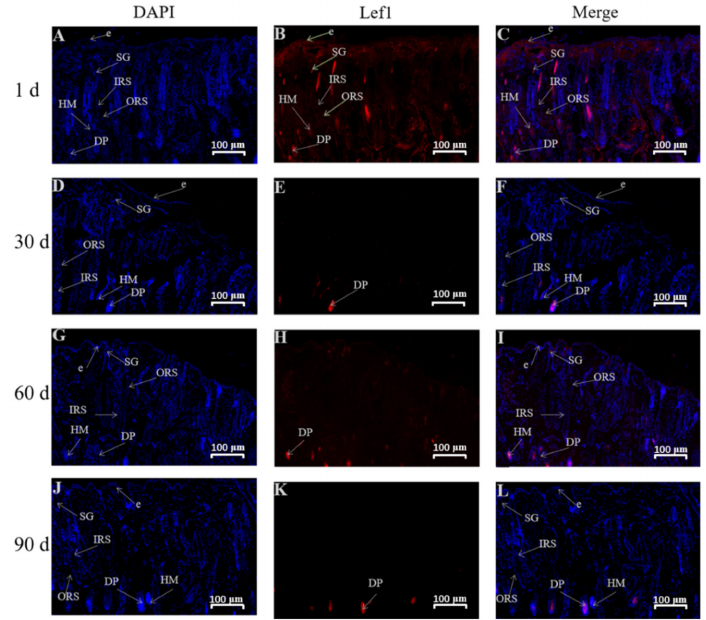
Figure 6. Immunofluorescence staining for Lef1 in skin tissues of Gansu Alpine Merino at various ages (10 × ). ( A , D , G , J ) The blue-colored tissue in the figure shows the DAPI-labeled nuclear fluores- cence coloring; ( B , E , H , K ) the red-colored tissue shows the fluorescence coloring of Lef1; ( C , F , I , L ) Fluorescent coloring after merging Lef1 with DAPI. ORS: outer root sheath; IRS: inner root sheath; DP: dermal papilla; HM: hair matrix; e: epidermis; SG: sebaceous glands.